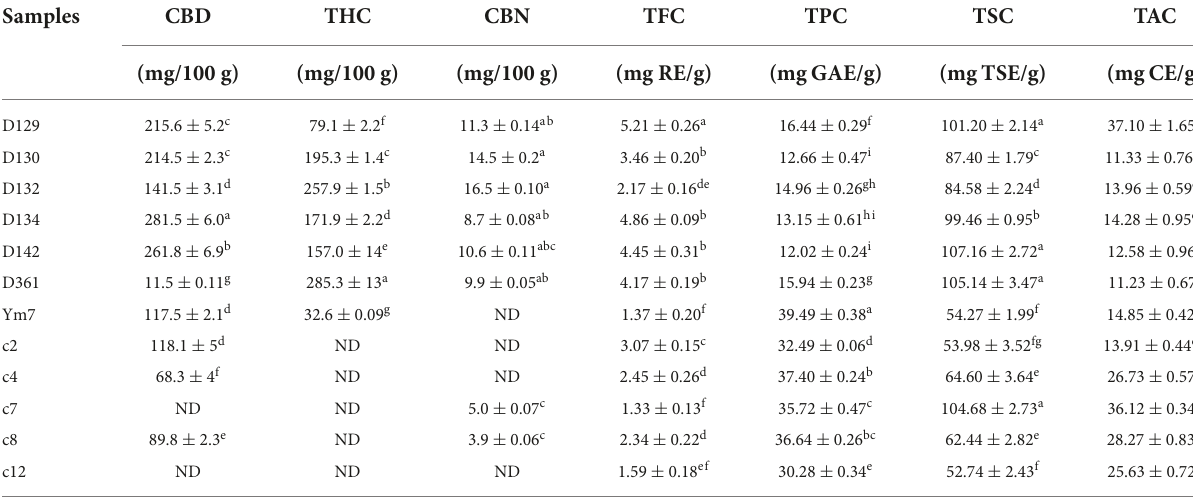
TABLE 1 The content of cannabinoids, flavonoids, phenolics, saponins, and alkaloids in hemp leaves from Shanxi and Hunan of China. Samples